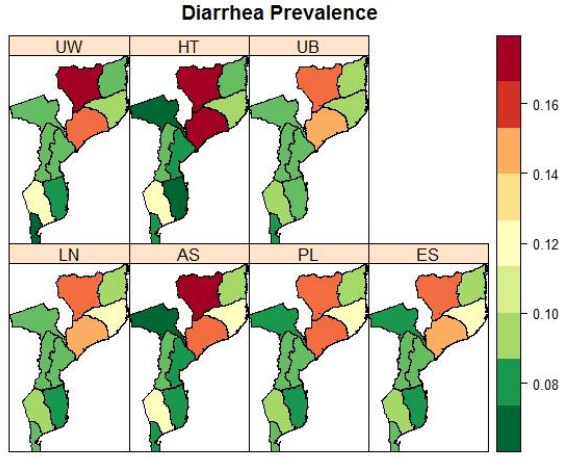
Figure 6. Maps of the observed (UW: unweighted and HT: Horvitz–Thompson) and spatial estimated prevalences of diarrhoea (UB: Unadjusted Binomial estimator (Model 1), LN: Logit-normal estimator (Model 2), AN: Arcsine-square root transformation estimator (Model 3), PL: Pseudo-likelihood esti- mator (Model 4), and ES: Effective Sample size estimator (Model 5)) by the province in Mozambique using IMASIDA 2015. 4. Discussion and Conclusions In this paper, we compared several statistical methods and their resulting estimates of spatial distributions of child malnutrition, fever and diarrhoea in Malawi and Mozam- bique using health survey data, accounting for health survey sampling weights. The re- sults of the study showed that the sampling weight-adjusted methods were the best fit- ting, a finding similar to previous studies [4 – 7]. Even though the estimated spatial pattern was similar, the models that adjusted for the sampling weight produced estimates that had lower variability (narrowed confidence intervals). Thus, using accounting for sam- pling weights produced estimates of disease risk that had an increased level of confidence. There are some concerning issues arising from our study. Firstly, although the arcsine transformation of the weighted prevalence was preferred for our application, it does not have an intuitive interpretation of the association between the binary outcomes and pre- dictors. Secondly, for the Mozambique case, the study used a province which has a much coarser level of geographical aggregation. This may have concealed variations at some higher spatial resolution needed for local policy decisions. We suggest, for future studies, performing spatial analyses at higher spatial resolutions, for example, at the district level. Thirdly, our analyses used univariate spatial methods for the conditions that could be correlated at ecological levels [30,31]. We are now extending these statistical methods to the estimation of joint spatial patterns of diseases. Finally, we did not perform any simu- lation study to compare the performance of the studied statistical methods for the estima- tion of spatial disease patterns using complex health survey data. However, we thought that this was not necessary for this study as we aimed to describe the sampling weights adjusting methods and illustrate their use on typical examples. Other previous research work considered their performances using simulations [4 – 7]. In conclusion, we recommend spatial epidemiology researchers consider incorporat- ing survey sampling weights in disease-mapping analyses for estimating the spatial dis- tribution of disease risks based on complex health survey data. The estimates are more precise, thus providing reliable supporting evidence to drive public health policy on tar- geting resources in areas of most need. Author Contributions: Conceptualization, S.R.C. and S.M.; methodology, S.R.C. and S.M.; software, S.R.C. and S.M.; formal analysis, S.R.C. and S.M.; data curation, S.R.C.; writing – original draft prep- aration, S.R.C., S.M., and F.M.; writing – review and editing, S.R.C., S.M., F.M., and M.d.R.O.M. All authors have read and agreed to the published version of the manuscript.